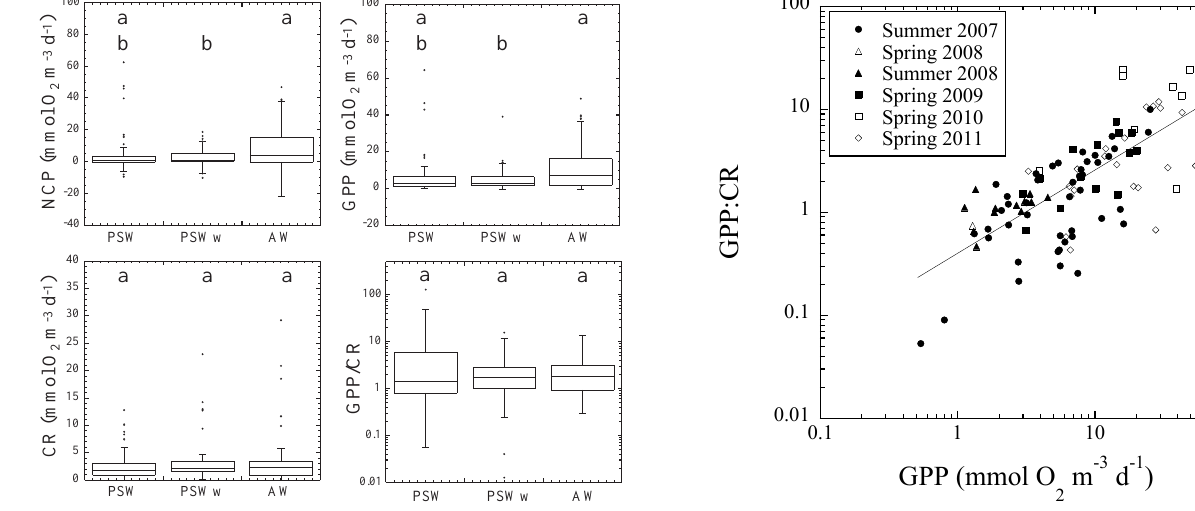
Fig. 5. The relationship between the ratio of gross primary pro- duction to community respiration (GPP/R) and gross primary pro- duction (mmolO 2 m − 3 d − 1 ) in the different cruises. The solid line shows the fitted regression